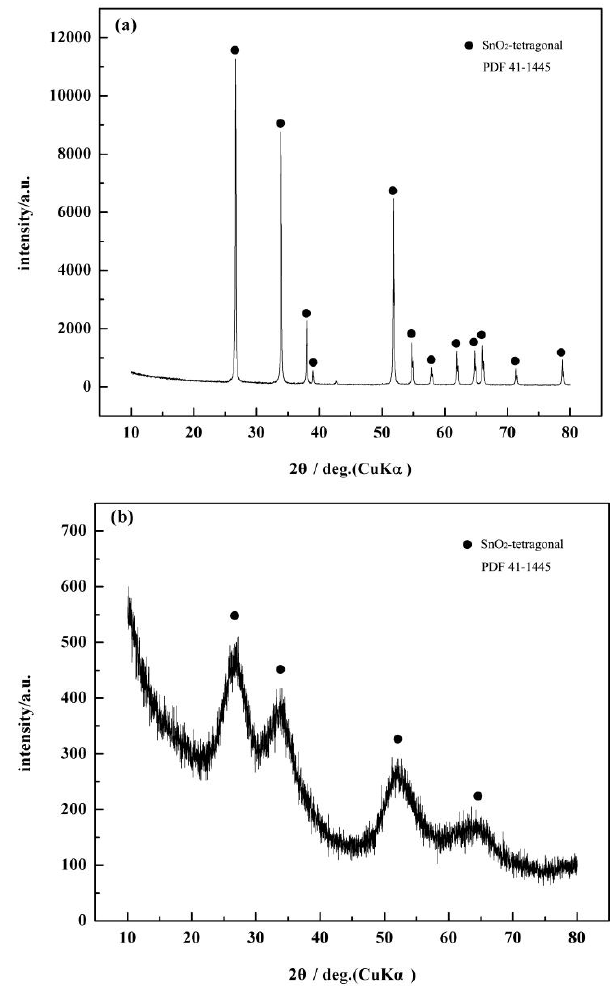
Figure 5. XRD patterns of the c-SnO 2 powders and the m-SnO 2 powders.: ( a ) c-SnO 2 ; and ( b ) m-SnO 2 .